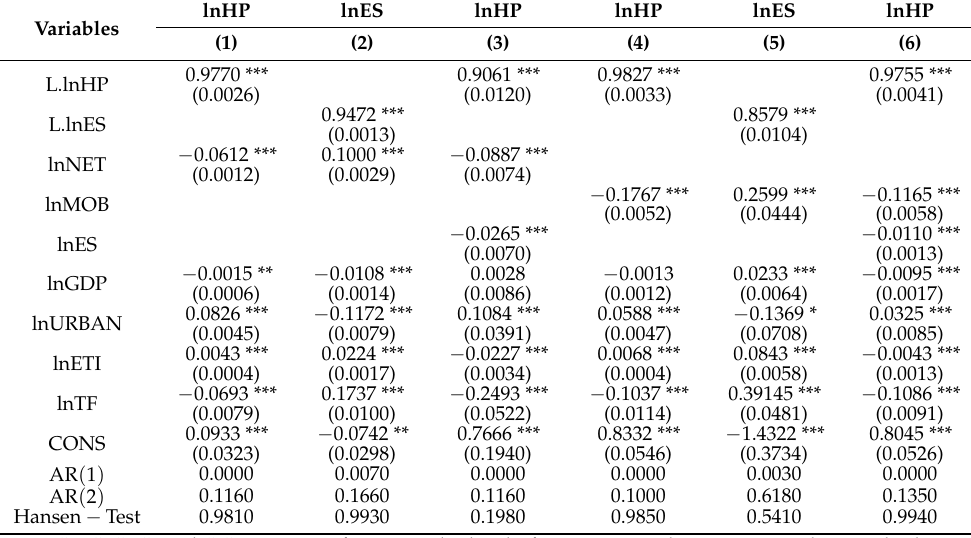
Table 7. Mechanism test results of energy consumption structure as the mediating